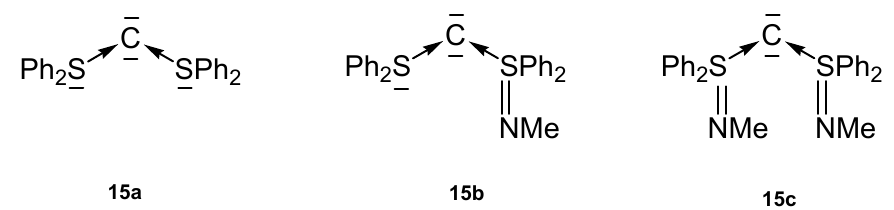
Figure 18. Sulfur based carbones 15 as ligands for transition metal complexes.